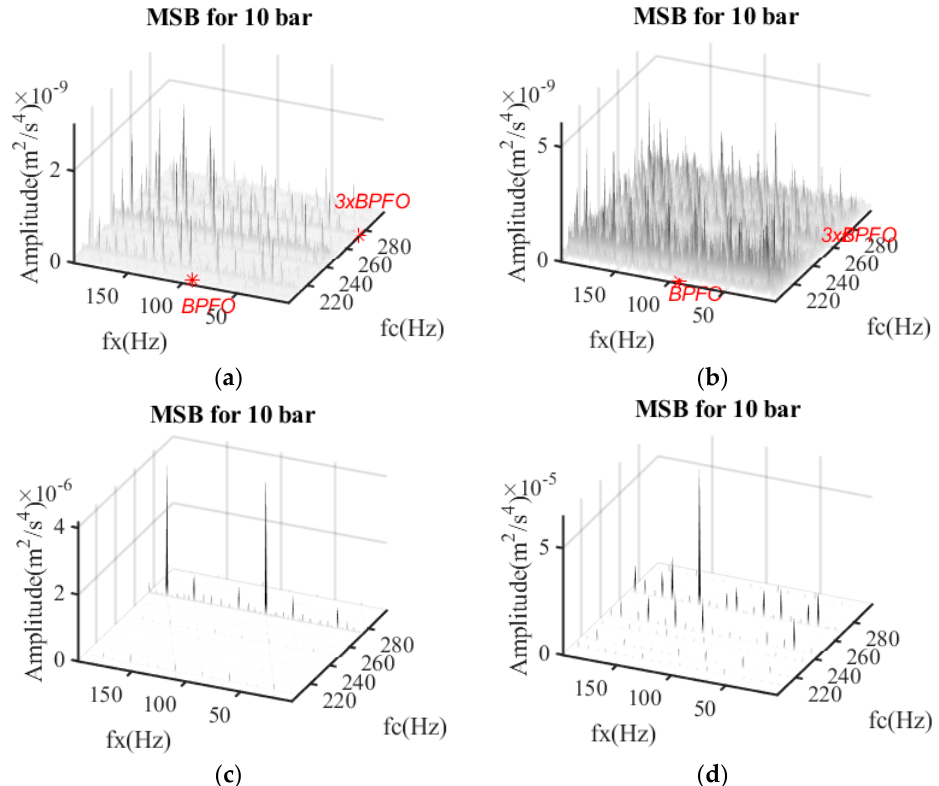
Figure 11. MSB magnitudes for ( a ) CN and ( b ) C4 bearings; MSB magnitudes for small defects on the ( c ) outer race and ( d ) inner race.